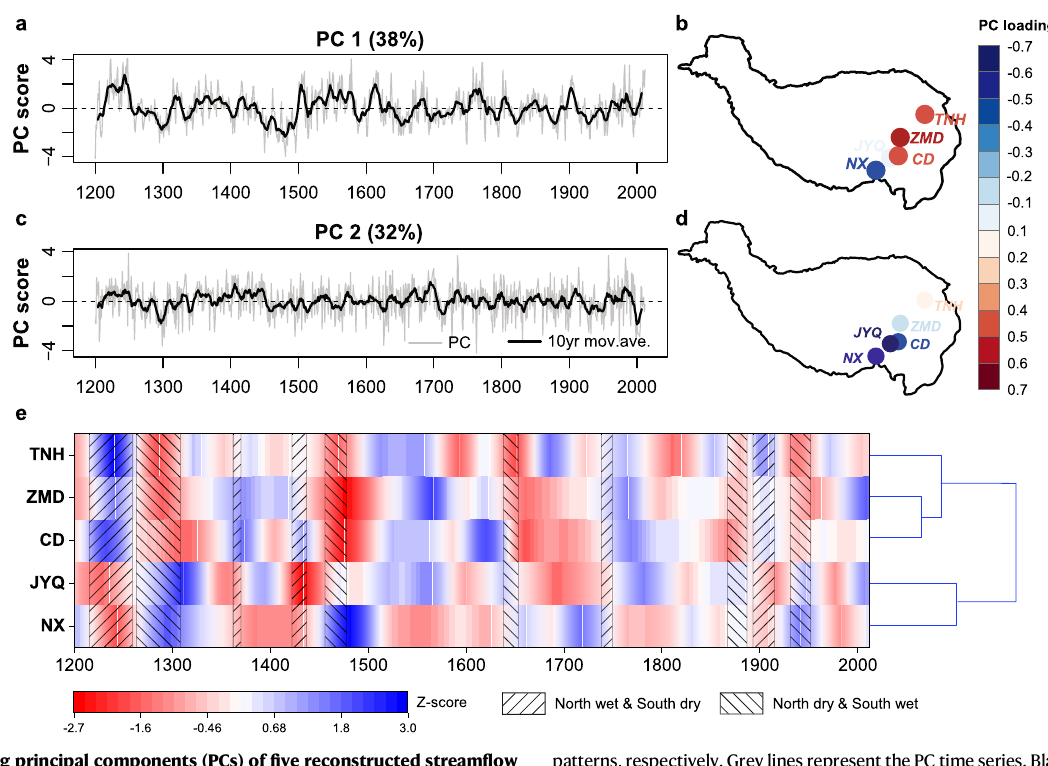
patterns,respectively.GreylinesrepresentthePCtimeseries.Blacklinesrepresent the 10-year moving average of the PC values. e Dendrograms and cluster spatiali- zations in two clusters based on the scaled 50-year low pass reconstructed stream fl ow for the fi ve gauging